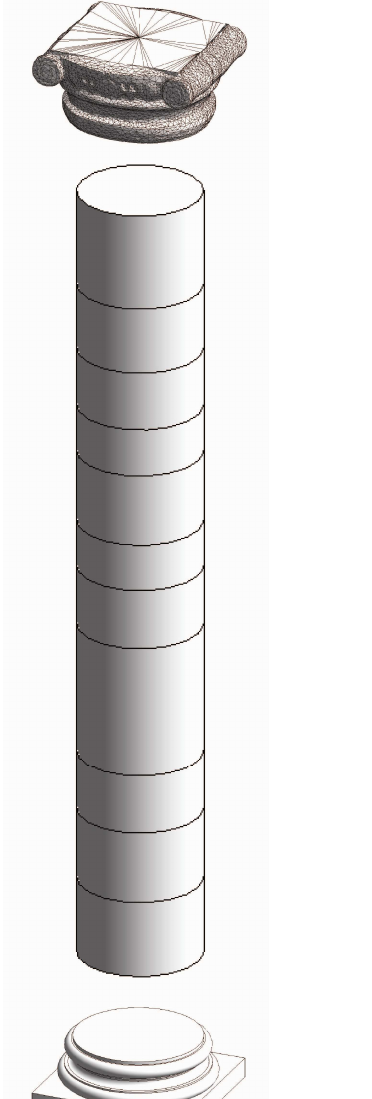
Figure 11. Starting from a partition in three segments, according to the vocabulary of the architectural orders, a first modeling of the column provided for a mesh modeling of the capital, an algorithmic modeling of the shaft and a parametric modeling for both the base and the plinth.